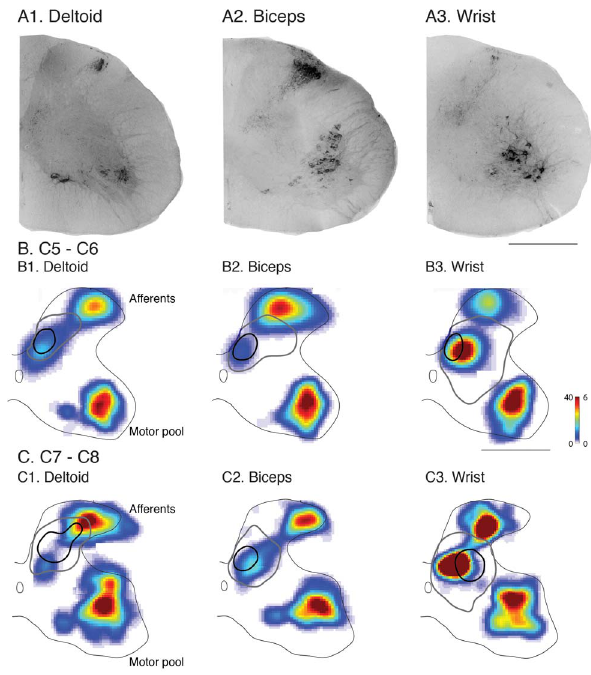
Figure 6. Cholera toxin b (CTb) labeling in the spinal cord after intramuscular injections and CST-interneuron topographic relationship. (A1–3) Examples of labeling with CTb subunit in one 40 m m section at level C7/C8, achieved after injection into either deltoids, biceps and the wrist extensor compartments. Matlab- generated heat maps of CTb-labeled spinal gray matter were produced from all sections for each muscle group at levels C5/C6 (B) and at levels C7/C8 (C). Heat maps show transganglionic labeling of the propriocep- tive afferents in the dorsal and intermediate region of spinal cord (afferent; i.e. laminae 2–6) and retrograde labeling of the motoneurons in the ventral regions of the spinal cord grey matter (motor pools; i.e. laminae 9). Spinal overlap of motor cortex CST joint zones and proprioceptive afferent terminations are also shown in B and C. As in Figure 3, CST termination contours were set at 60% threshold (black contour) and 10% threshold (gray contour). The color bar demonstrates density of labeling as pixels per mm 2 for proprioceptive afferents (left axis) and cells per mm 2 for motor pools (right axis). Scale bar is 500 m m. Muscle afferents transganglionically-labeled with CTb termi- nated within two distinctive regions, one within laminae 2–4 of the dorsal horn and the other within laminae 5–6 (Figure 6A1–A3; representative C7/C8 sections). Density maps (rows B, C) show that the dorsal fields were shifted somewhat for each muscle,